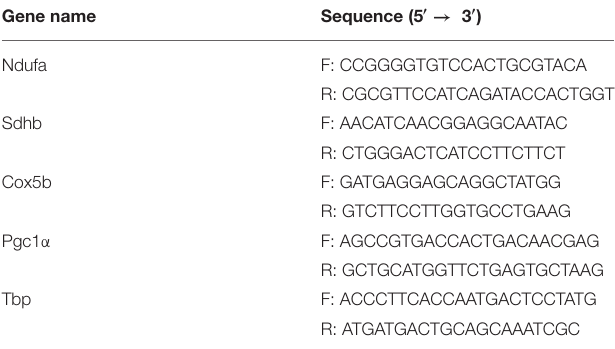
TABLE 1 | RT-qPCR primers